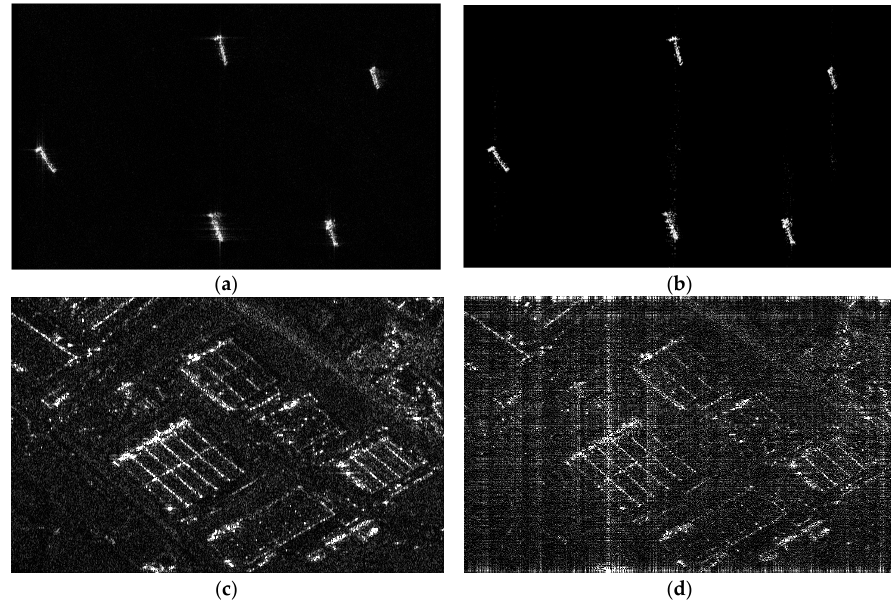
Figure 1. Reconstructed results. Compared with the result ( a ) reconstructed from raw data under the Figure 1. ( a ) Reconstructed result of ocean containing ships from Nyquist samples based on chirp Nyquist sampling method based on chirp scaling, most details of ships in ( b ) are maintained and scaling; ( b ) Reconstructed result of ocean containing ships from sub-Nyquist samples based on reconstructed from sub-Nyquist samples based on compressive sensing (CS). Contrasting with ships compressive sensing (CS); ( c ) Reconstructed result of an urban scene from Nyquist samples based on chirp scaling; ( d ) Reconstructed result of an urban scene from sub-Nyquist samples based on